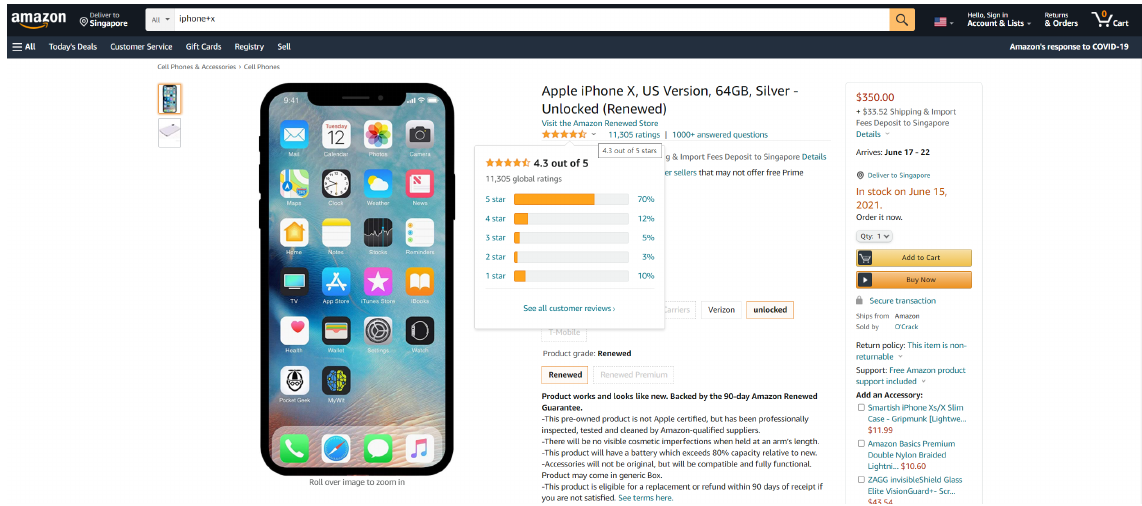
Figure A6. Amazon product page of a renewed iPhone